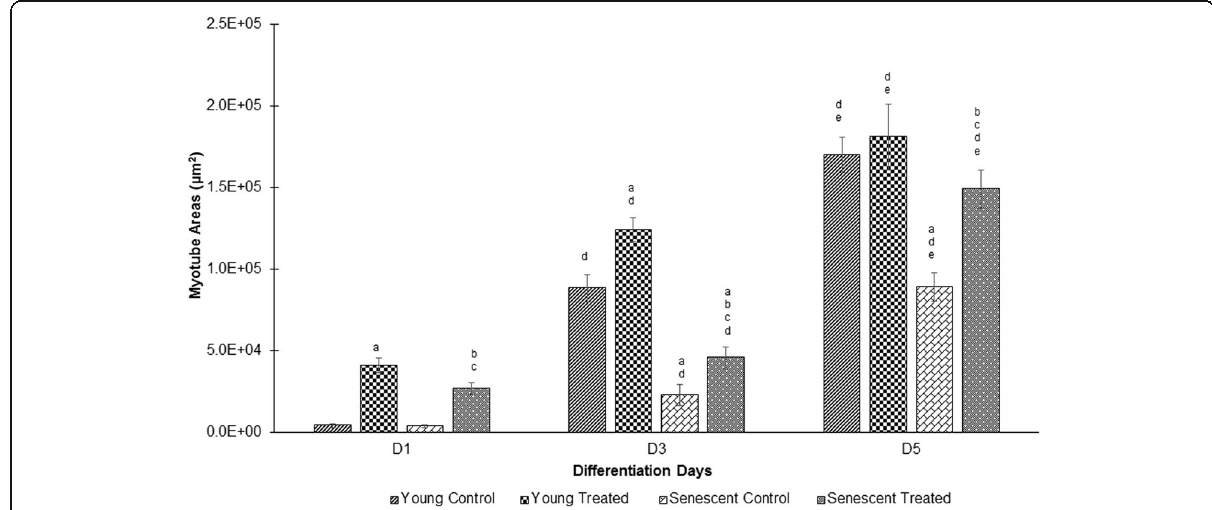
Fig. 3 Effect of TRF on myoblasts differentiation as measured by myotube surface area. a Denotes p < 0.05 compared to young control, b p < 0.05 compared to senescent control, c p < 0.05 compared to young treated, d p < 0.05 compared to day 1 of the same treatment and e p < 0.05 compared to day 3 of the same treatment. Data are presented as mean ± SD, n =